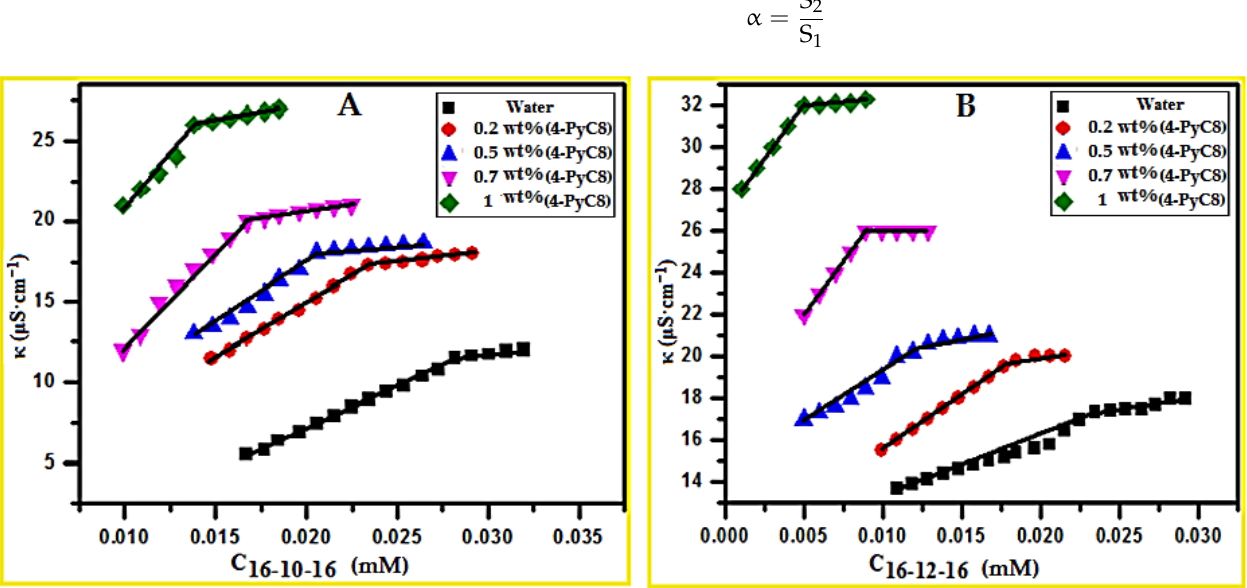
Figure 1. Specific conductivity ( µ S · cm − 1 ) vs. concentration (mM) of the gemini surfactants 16-10-16 ( A ) and 16-12-16 ( B ) in the presence of 0.2, 0.5, 0.7 and 1 wt% of the IL 4-PyC8 at 300